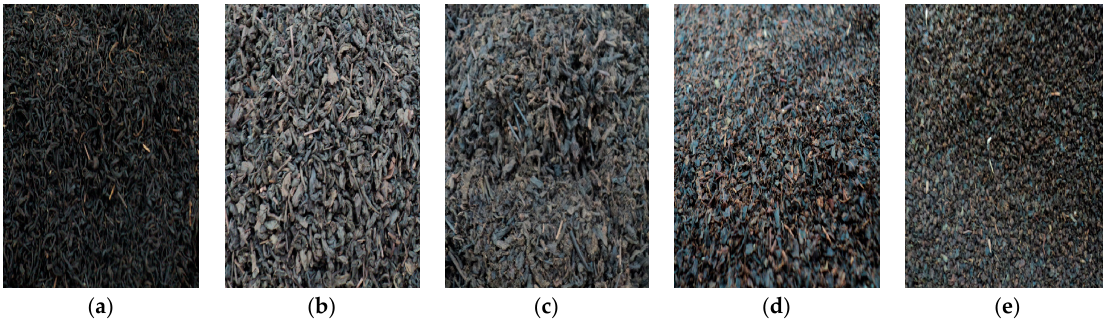
Figure 5. ( a – e ) Variations in V r and m.c (%) at (25 ± 1) °C. ( f ) Sensitivity of measured V r respect to m.c .